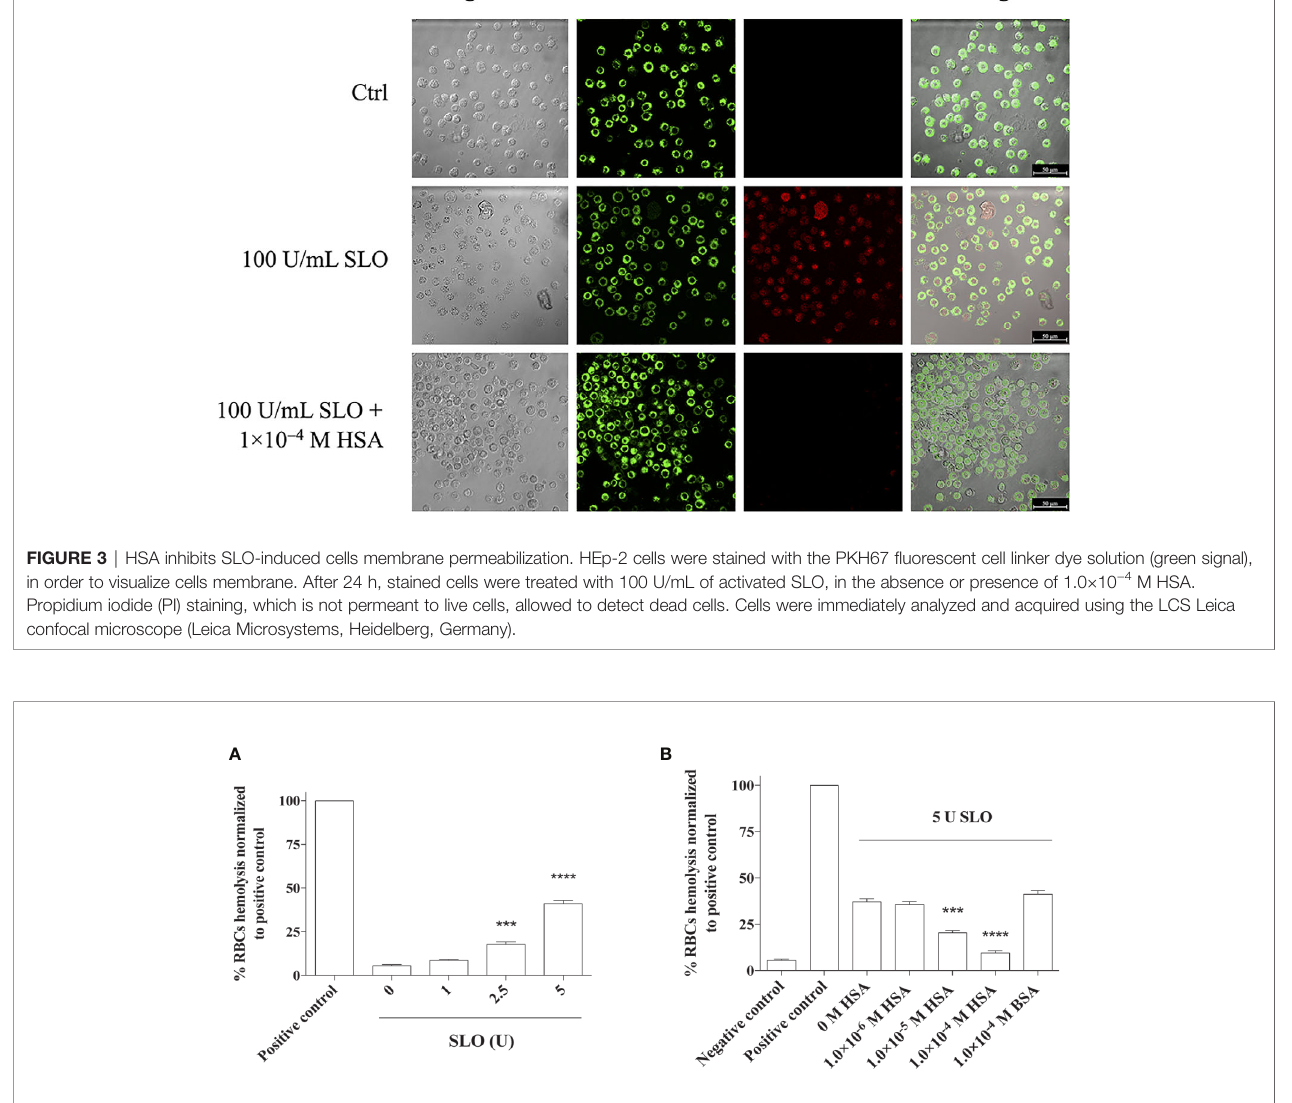
FIGURE 4 | Effect of HSA and BSA on the SLO toxin-mediated red blood cells (RBCs) hemolysis. RBCs were isolated from the human whole blood of four healthy donors and treated with (A) 0, 1, 2.5 and 5 U of activated SLO for 1 h at 37°C. (B) Considering that 1 U of activated SLO causes a 50% lysis of 50 m L of 2% human RBCs, we used 5 U of activated SLO to cause the 50% lysis of 190 mL of 2% human RBCs. RBCs were treated with the toxin for 1 h at 37°C, in the absence or presence of 1.0×10 − 6 M to 1.0×10 − 4 M HSA. The protective effect of 1.0×10 − 4 M BSA was tested. As negative control, RBCs were incubated with PBS, in the absence of activated SLO. As positive control, RBCs were disrupted with 2% Triton X-100. The concentration of released hemoglobin was quanti fi ed by measuring the absorbance at 541 nm. Results were represented as the percentage of lysed RBCs (assuming as 100% the positive control) derived from three independent experiments ± SD (One-way ANOVA, *** P < 0.001 and **** P < 0.0001 compared with cells treated with 600 U of activated SLO in the absence of